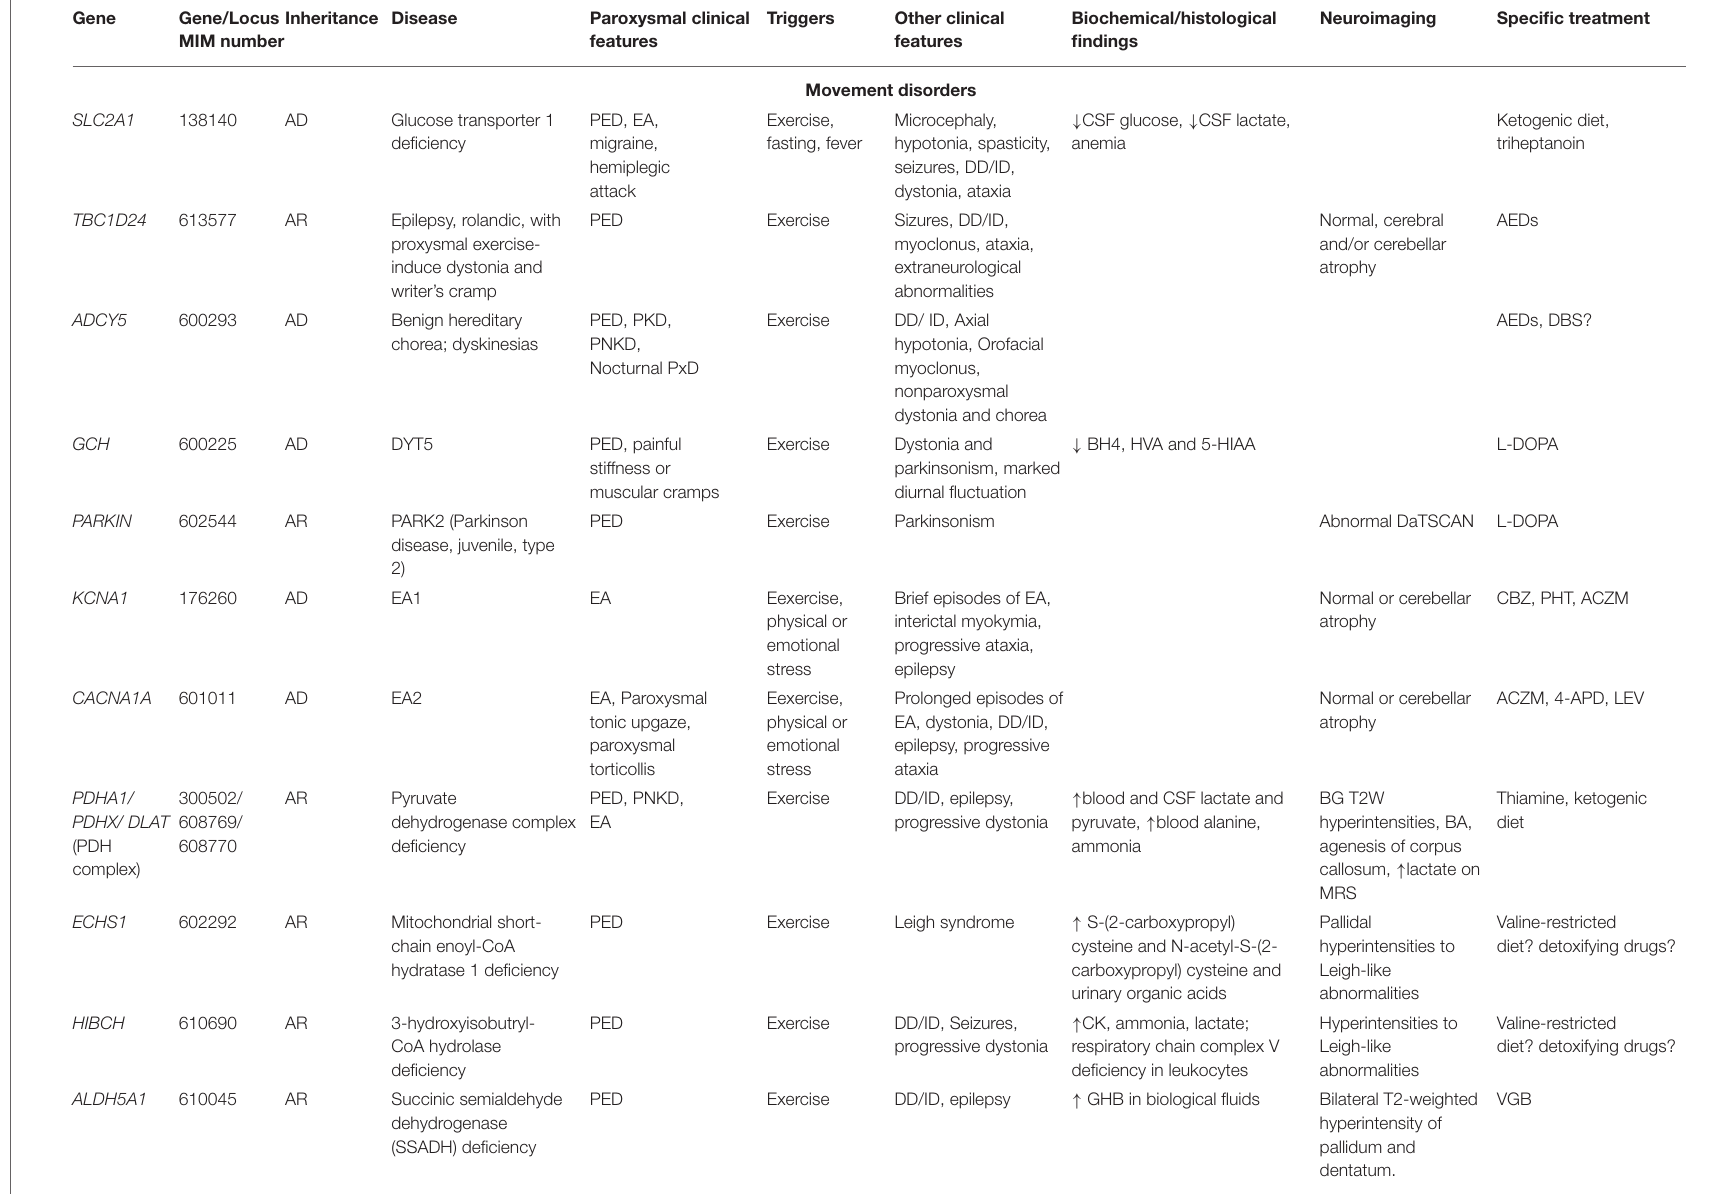
TABLE 1 | Main genetic causes of PENS and related clinical, biochemical/histological/neuroimaging findings and treatments.